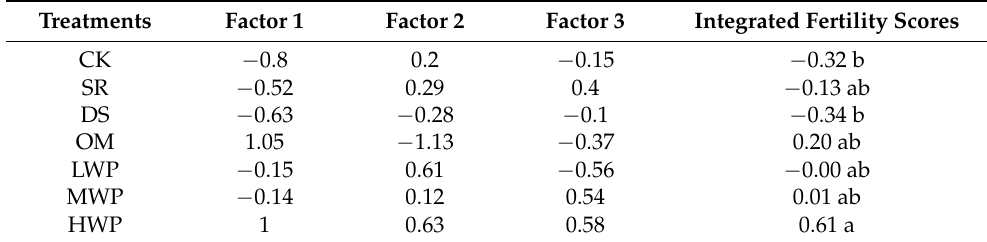
Table 4. Principal component scores and integrated fertility scores of soil fertility under different treatments in 2021.